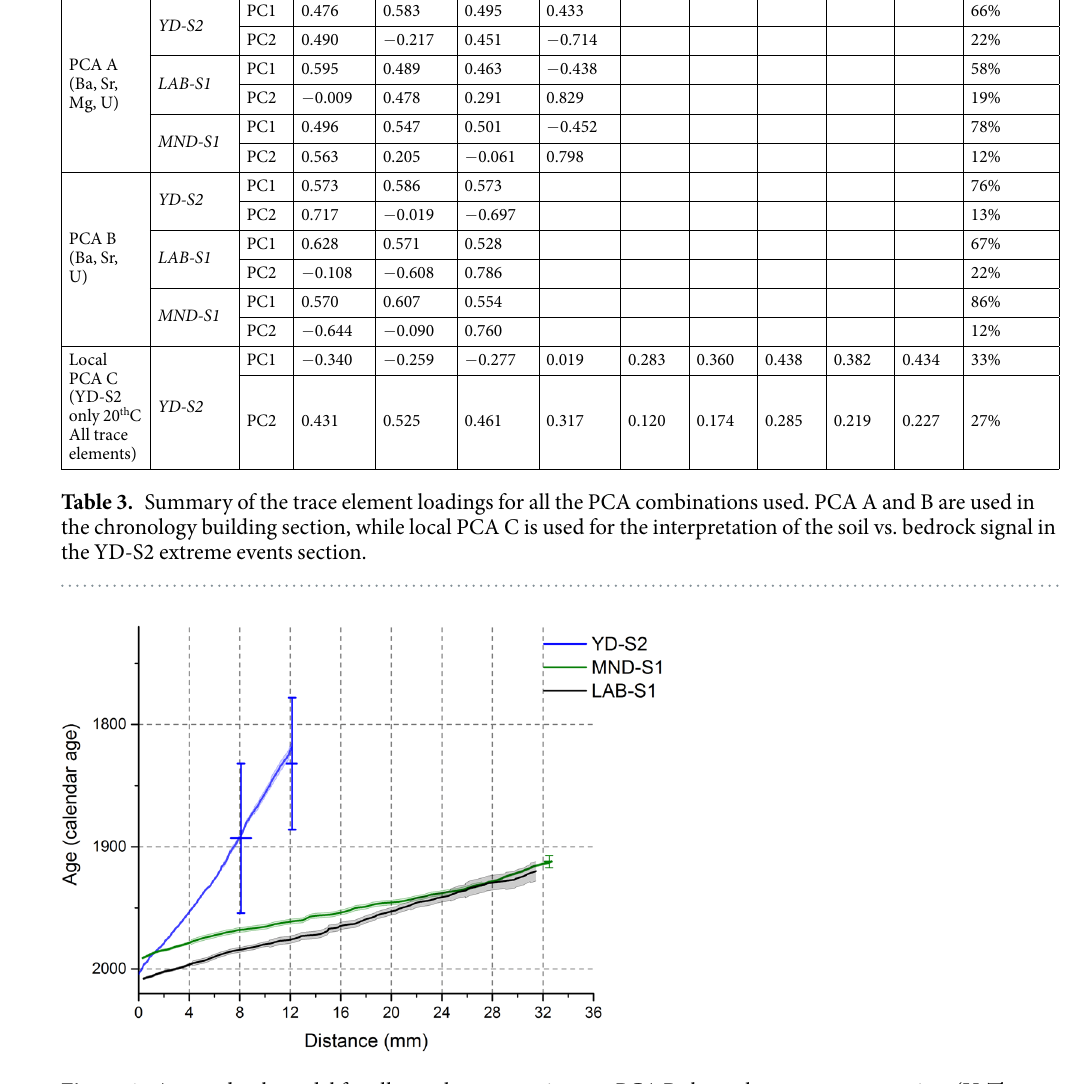
Figure 4. An age depth model for all samples, comparing our PCA B chronology vs. age constraints (U-Th dates for YD-S2, and substrate dates for MND-S1). The x-axis is distance below the top of the stalagmite. The age uncertainty for LAB-S1 is ± 253 years; hence the basal age of this sample could not be